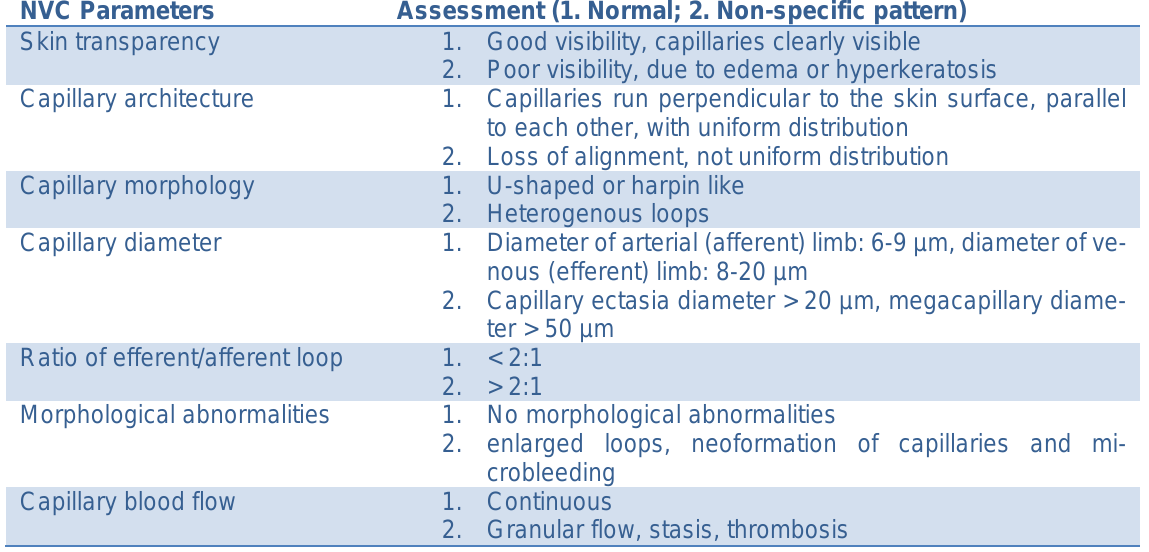
Table 2: NVC parameters and assessment NVC